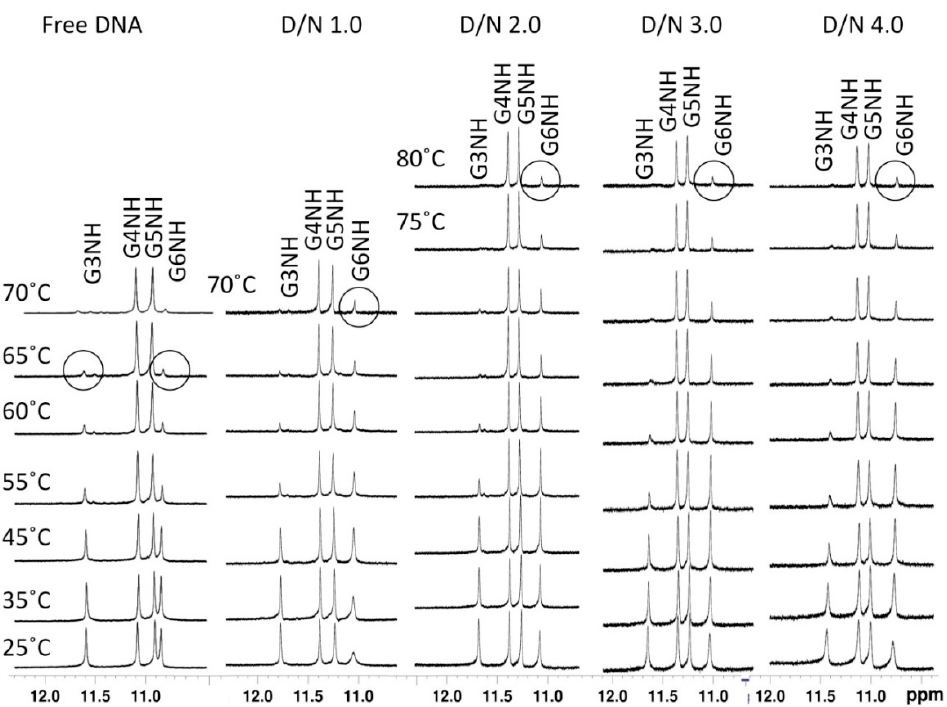
Figure 8. One-dimensional (1D) 1 H NMR spectra of imino protons showing the thermal melting profile of the free [d-(TTGGGGT)] 4 and daunomycin [d-(TTGGGGT)] 4 complex at different D/N ratios and different temperatures.